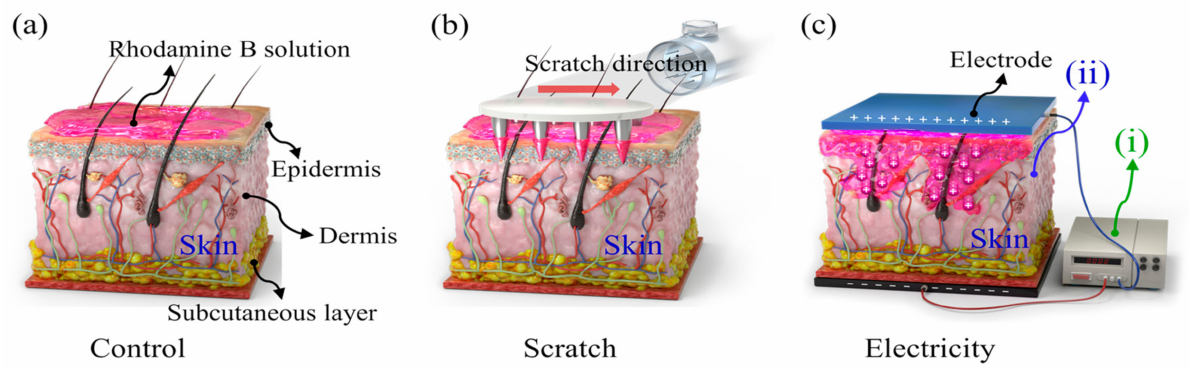
Figure 1. Schematics of ( a ) control, ( b ) needle scratch condition, and ( c ) electrically induced ion- tophoresis for transdermal transmission. Schematics of ( i ) power supply and ( ii )